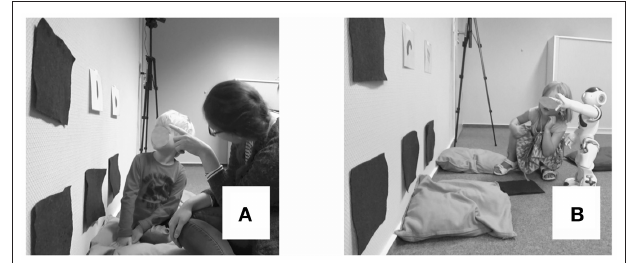
FIGURE 2 | Teaching of the novel word either by (A) the human or (B) the robot interlocutor.